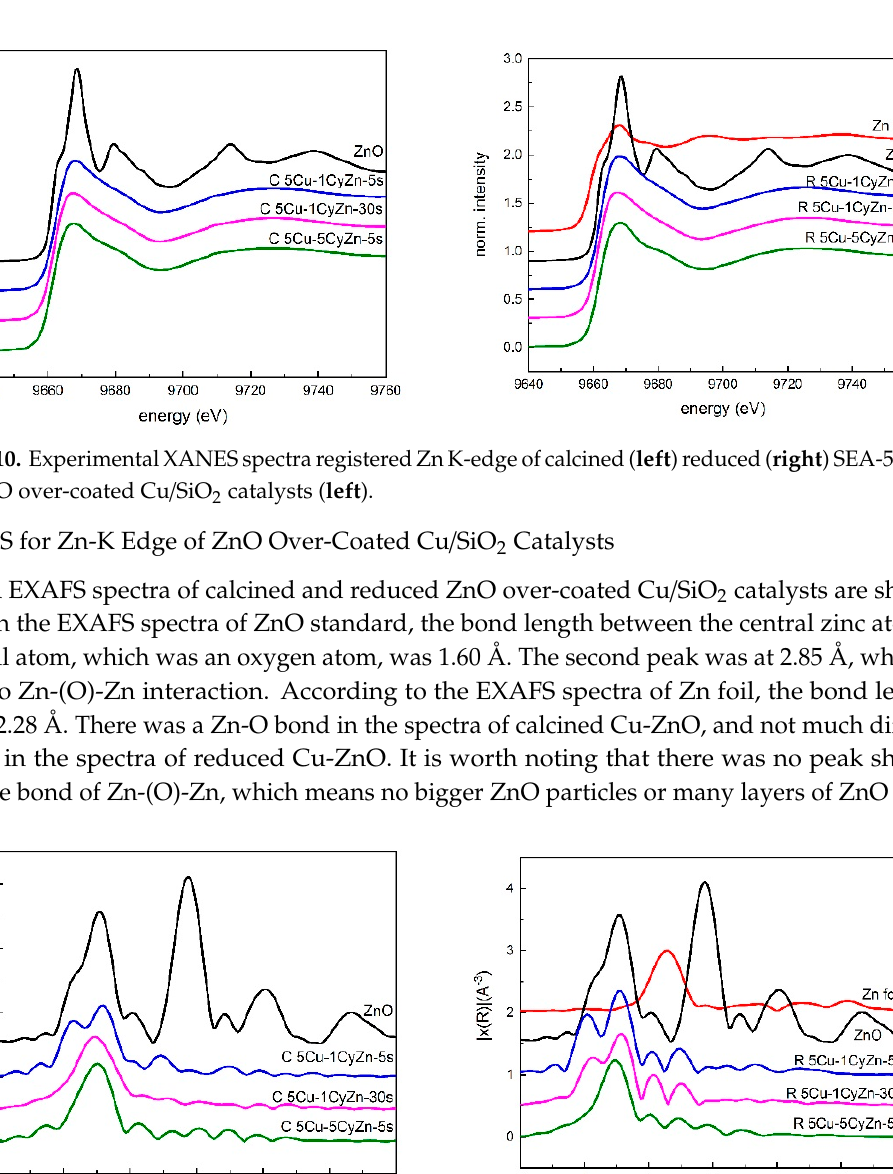
11 of 18 Figure 9. Experimental EXAFS spectra registered Cu K-edge of calcined ( left ) and reduced ( right ) SEA-5Cu and ZnO over-coated Cu/SiO 2 catalysts. 2.3.3. XANES for Zn-K Edge of ZnO Over-Coated Cu/SiO 2 Catalysts The Zn XANES spectra of calcined ZnO over-coated Cu/SiO 2 catalysts are shown in Figure 10 (left). The absorption edge was at 9662 eV, disclosing the existence of bivalent Zn. However, the spectra of ZnO over-coated Cu/SiO 2 catalysts were considerably different from that of ZnO standard. Compared to the spectrum of ZnO, the peaks at 9663.8 and 9668.4 eV assigned to 1s–4sp and 1s–4p transitions, were merged to one peak at 9667.5 eV in the spectra of the catalysts. The peaks at 9679.3 and 9683.4 eV were smoothed and became a shoulder (9681.1 eV), which was assigned to multiple scattering (midrange order and short-range order) [31]. This peak was only shown in the spectrum of 5Cu-5CyZn-5s instead of the catalysts with one cycle of ZnO deposition ， since there was a single layer of ZnO appearance with an uncoated area on the catalyst 5Cu-1CyZn-5s and a relatively uniform ZnO layer on the catalyst 5Cu-1CyZn-30s. The difference between the spectra of Cu-ZnO and the spectrum of ZnO was also because the Zn 2+ on the catalysts, which existed as molecules or much smaller particles, were mostly influenced by the substrate, SiO 2 .